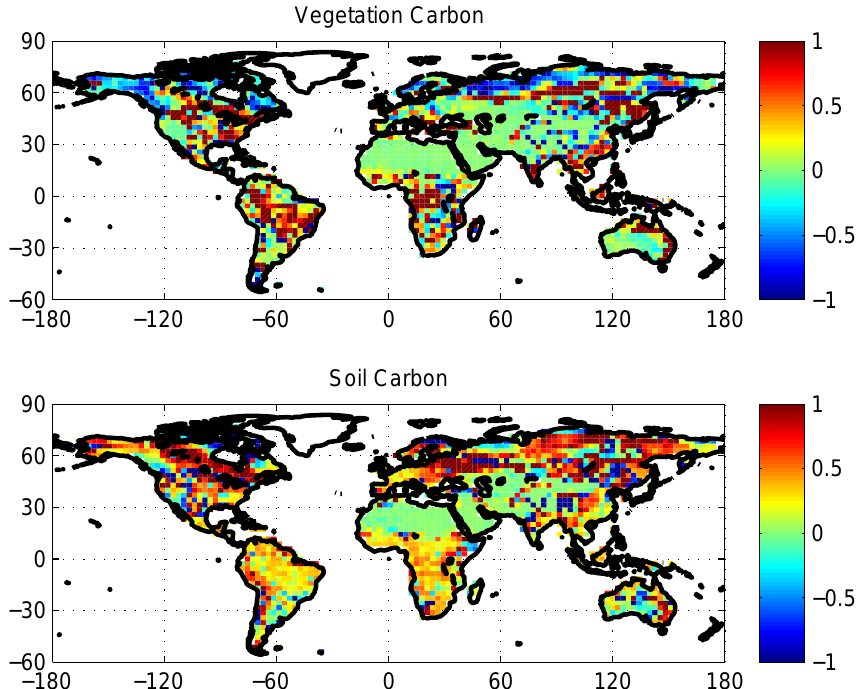
Fig. 7. Mean changes (GEO PIN5 minus REF) in total land (top) vegetation and (bottom) soil carbon content due to additional volcanic forcings computed over 2090–2099 period. Units are in [KgCm − 2